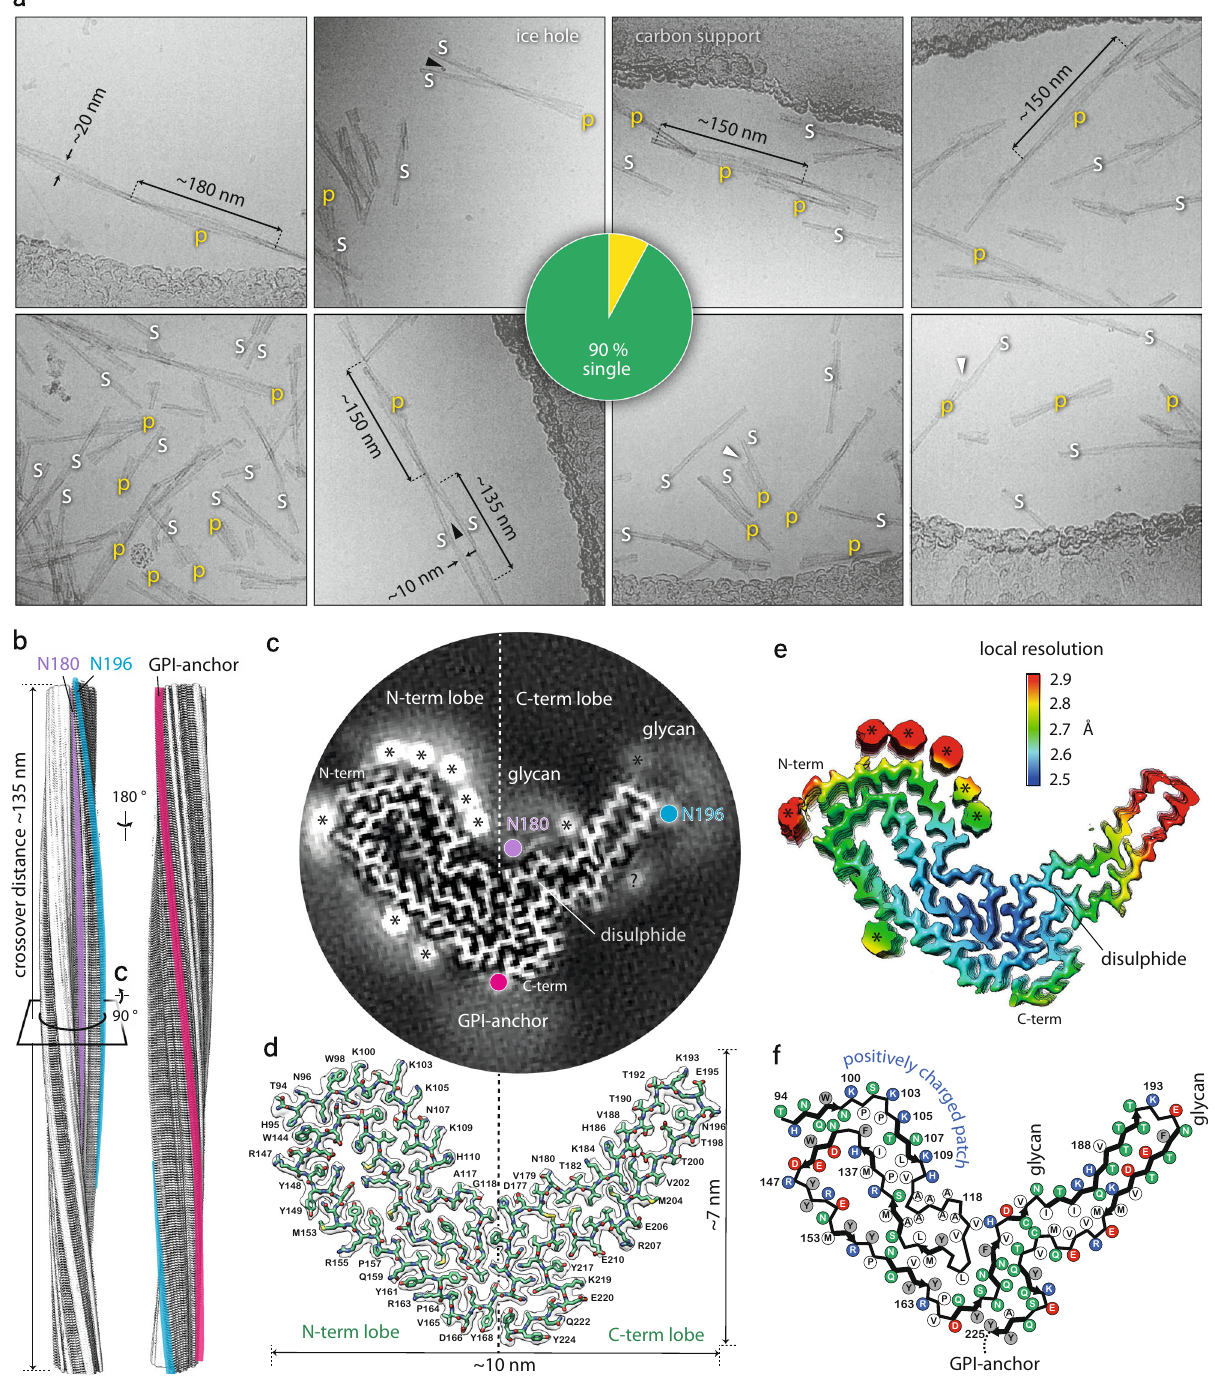
Fig. 1 RML fi bril morphologies and 3D reconstruction and atomic model of the RML proto fi lament core. a Selected cryo-EM images (300 kV FEI Krios G3i, K3 camera) showing examples of single RML proto fi laments (s) and paired proto fi laments (p) with approximate measurements of widths and crossover distances. Black arrowheads, partly intertwined proto fi laments; white arrowheads, ‘ notched ’ paired proto fi laments. Pie chart, quanti fi cation of paired proto fi laments in 6000 micrographs. b Rendered cryo-EM map (isosurface) view of both sides of a helical crossover, with annotated locations of N-linked glycans and the GPI-anchor. c Cross-section (as indicated in b ) of the unrendered map (pixel size: 1.067 Å) showing the protein core and the non- protein extra densities, with annotations coloured as in b ; *, likely locations of phosphotungstate polyanions (cages) near positively charged residues;?, unassigned density. See also Supplementary Fig. 4b. d Protein-only density of a single amyloid rung with the fi tted atomic model of the mouse PrP chain shown with sticks and coloured by heteroatom: C, green; N, blue; O, red; S, yellow. e Local resolution of the map calculated with Relion 3.1 LocRes. *, as in c . f Diagram of the PrP subunit. Positions of amino acid side chains are indicated with circles (positively charged, blue; negatively charged, red; neutral, green; hydrophobic, white; aromatic, grey) on either side of the backbone (black line). β -strands are indicated with thick black arrow-headed lines.